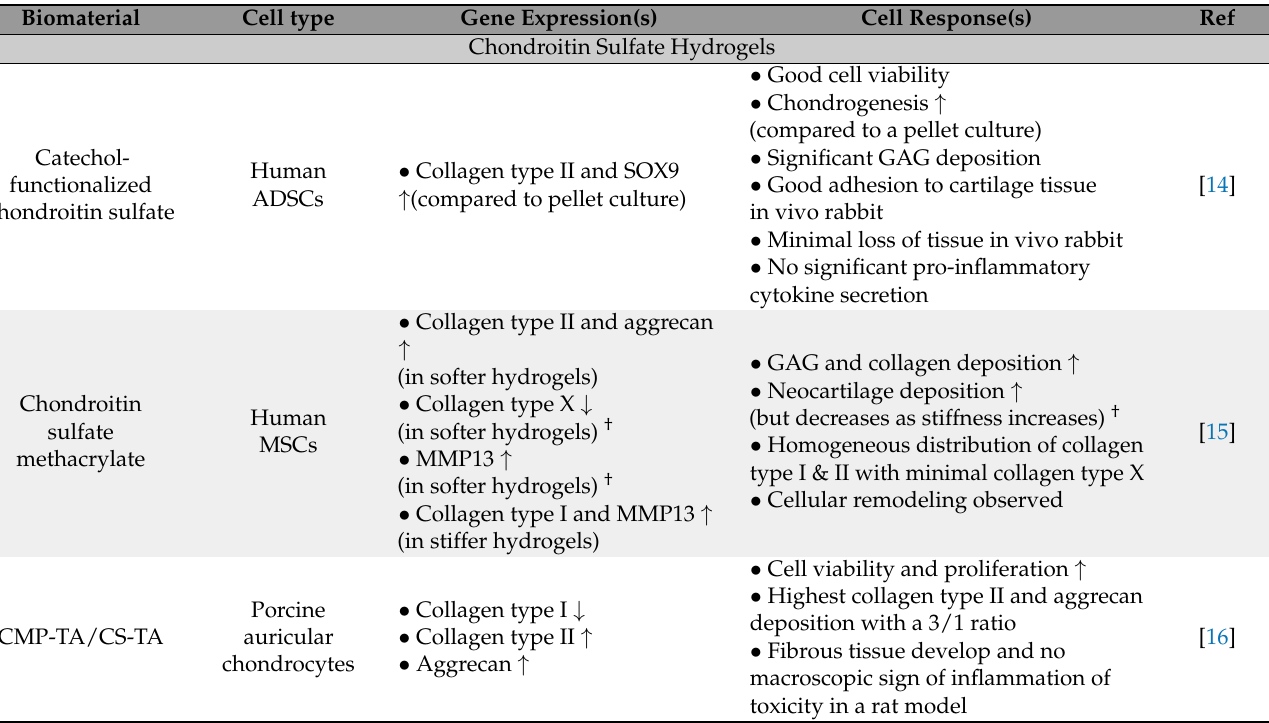
Table 2. Sulfated hydrogels for cartilage and IVD supporting phenotype with relevant gene expressions and cell responses.